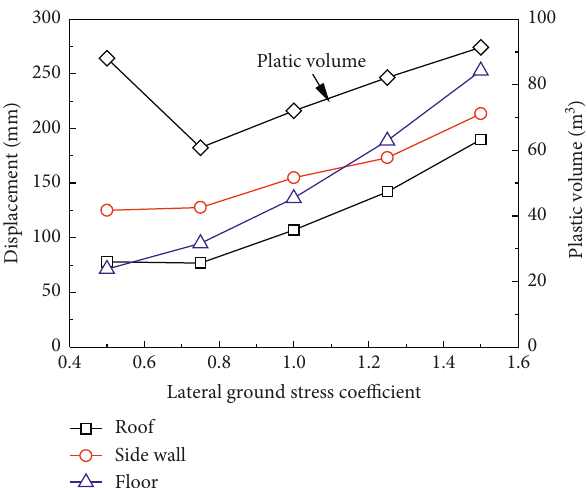
Figure 9: Variation curves of displacements and plastic zone volumes with lateral ground stress coefficient.